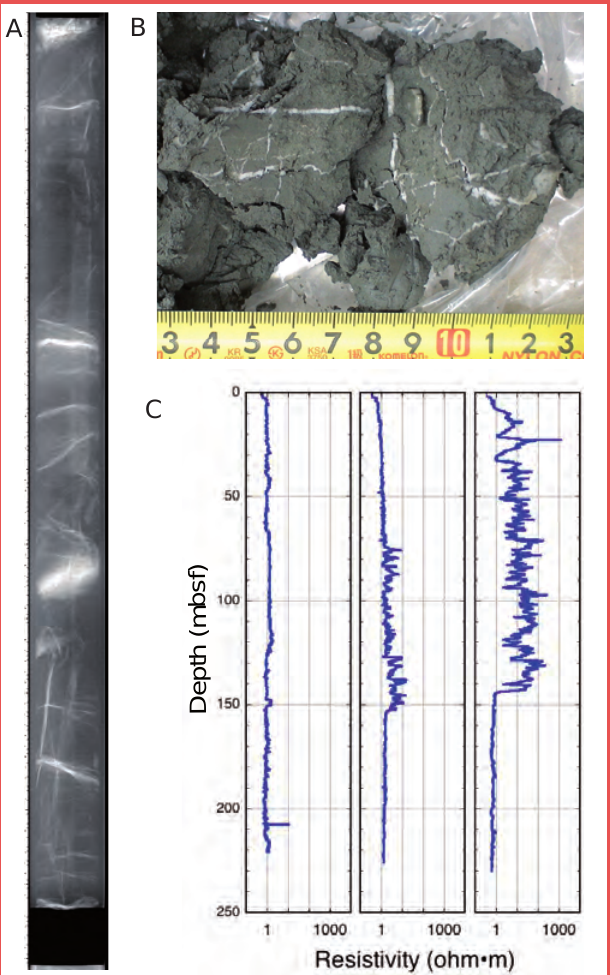
Figure 4. [A] X-ray image collected in the PCATS from Expedition UBGH-1 showing gas hydrate in veins and layers, similar to the core shown in Fig. 2 ; [B] picture of gas hydrate veins from another UBGH-1 core; [C] logging-while-drilling electrical resistivity data from the three “type” locations cored, showing resistivity profiles differing by orders of magnitude. Gas hydrate was present at all three